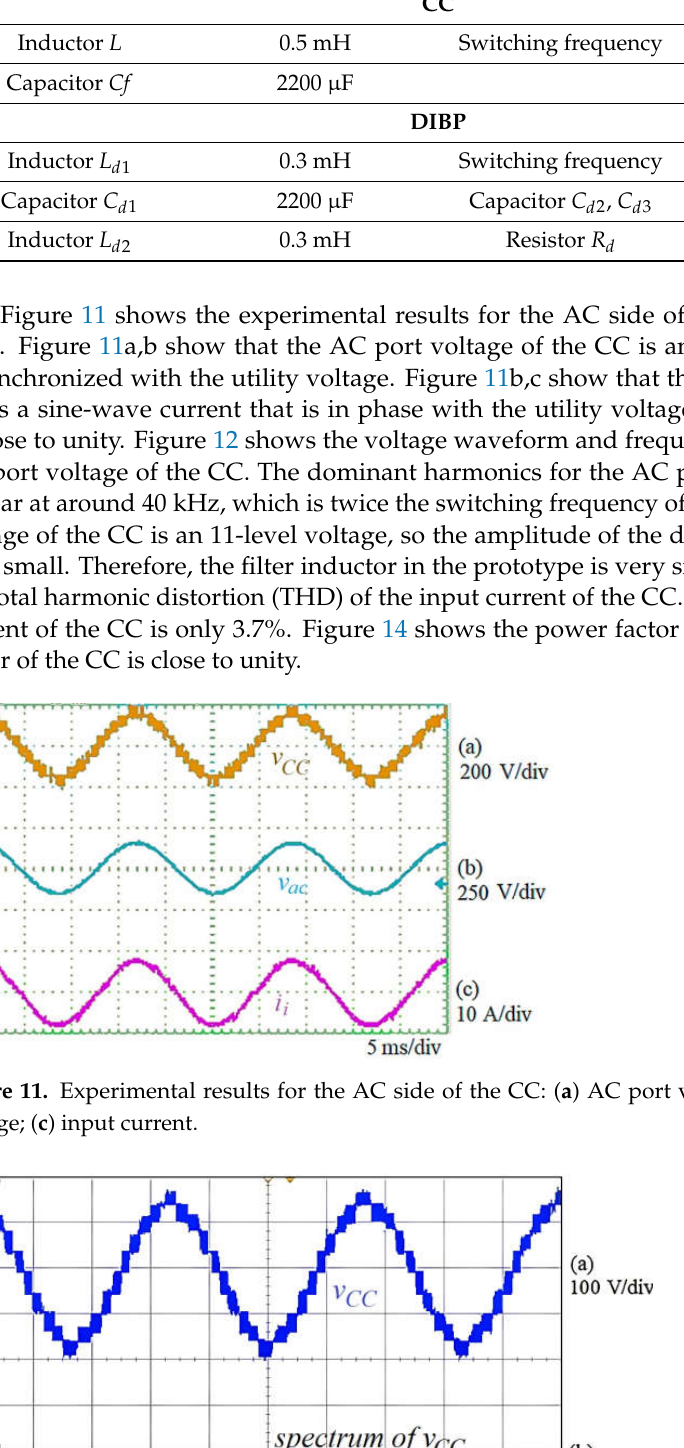
Figure 13. THD of the input current of the CC.